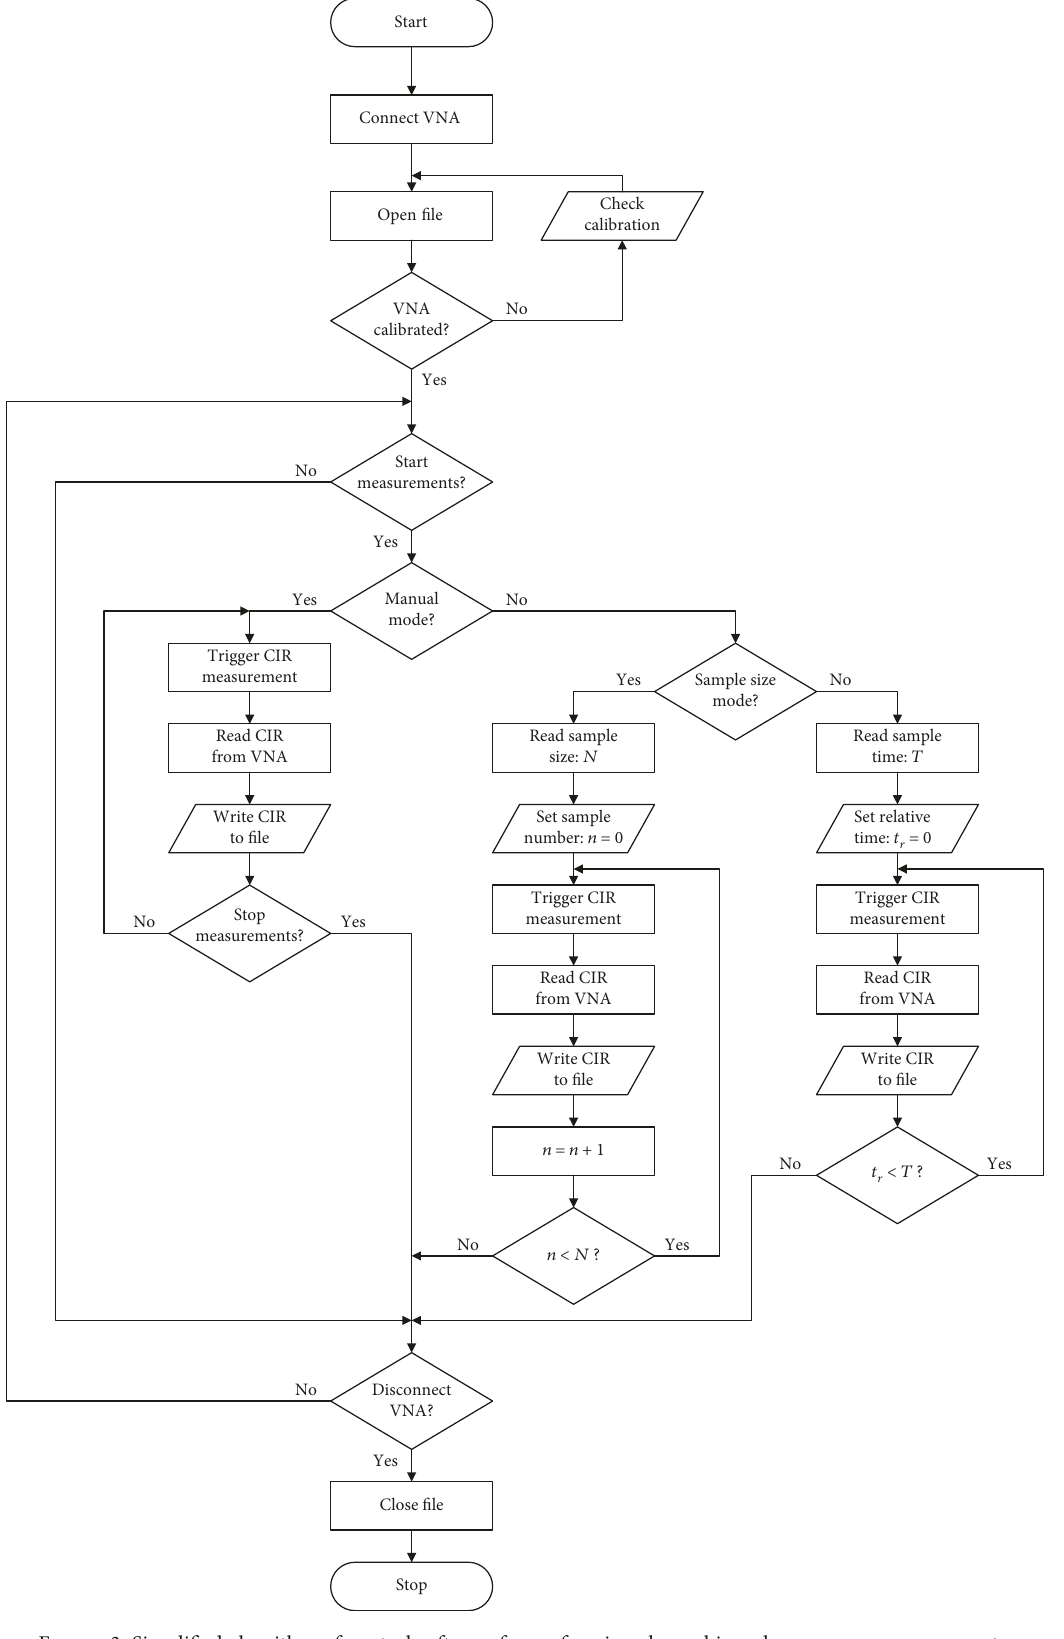
Figure 3: Simpli fi ed algorithm of control software for performing channel impulse response